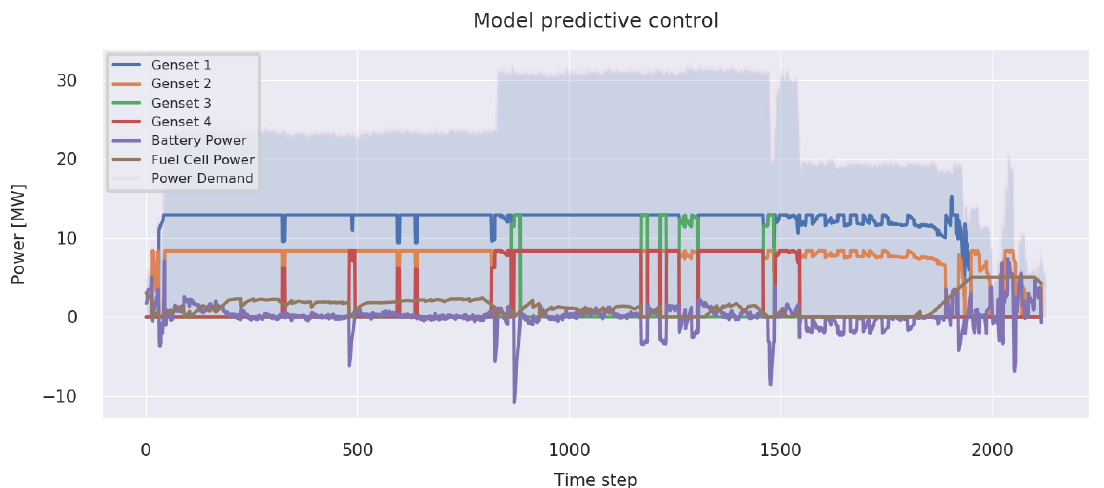
Figure 8. Mediterranean trip unit commitment with model predictive